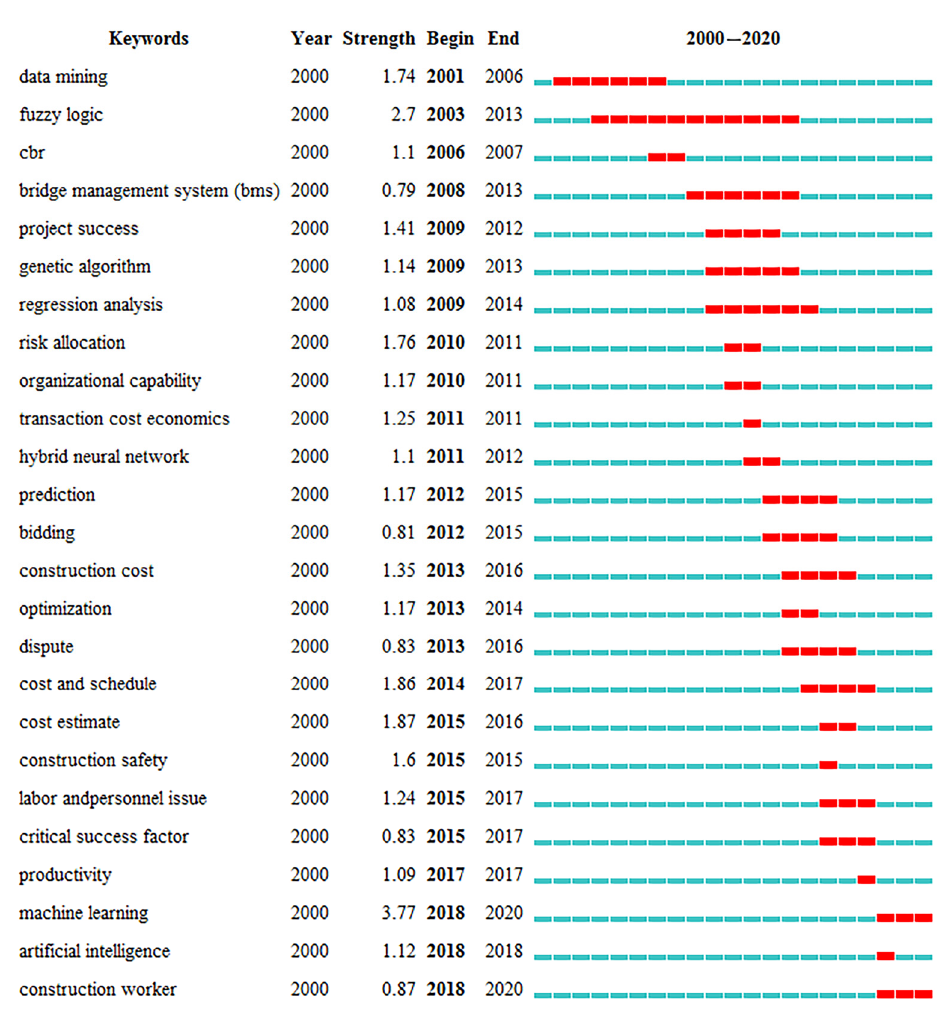
Figure 6. Top 25 keywords with the strongest citation bursts in the selected literature.